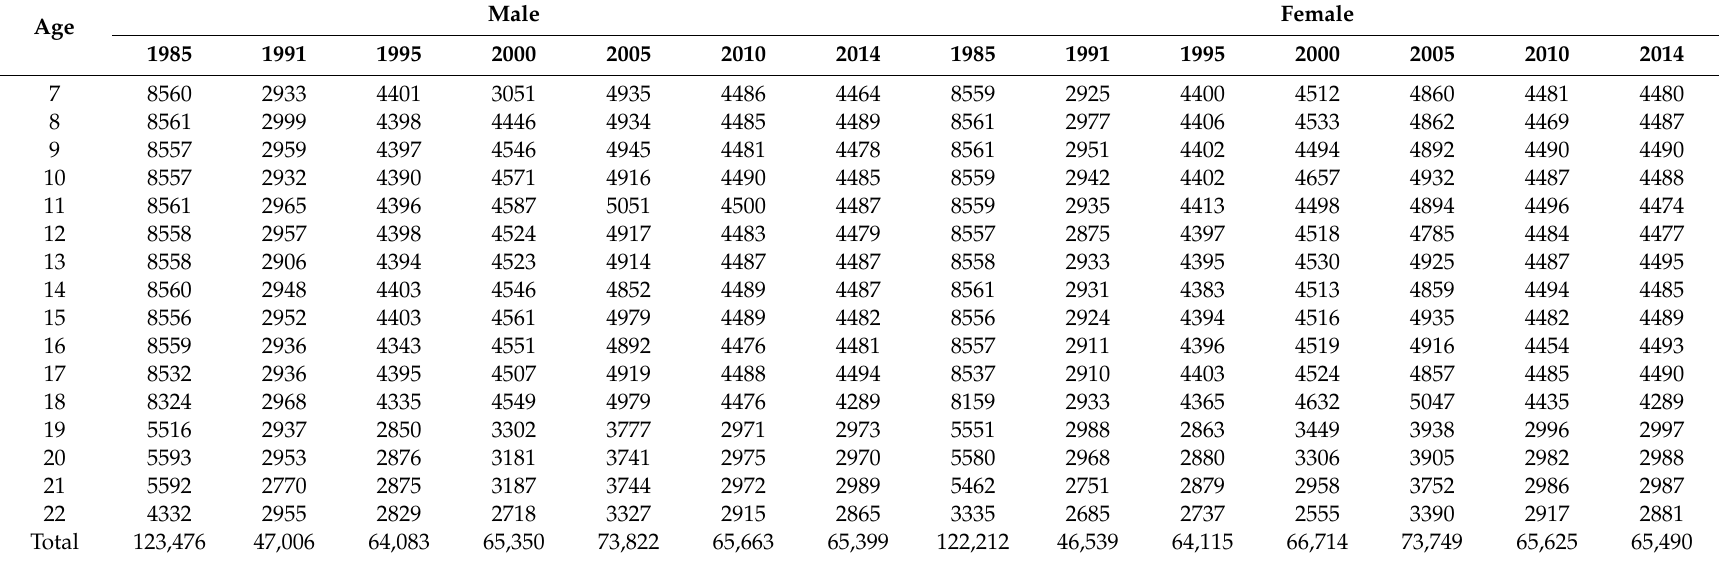
Table 1. Sample Sizes at Each Examination Period in CNSSCHA (Aged 7–22 years),